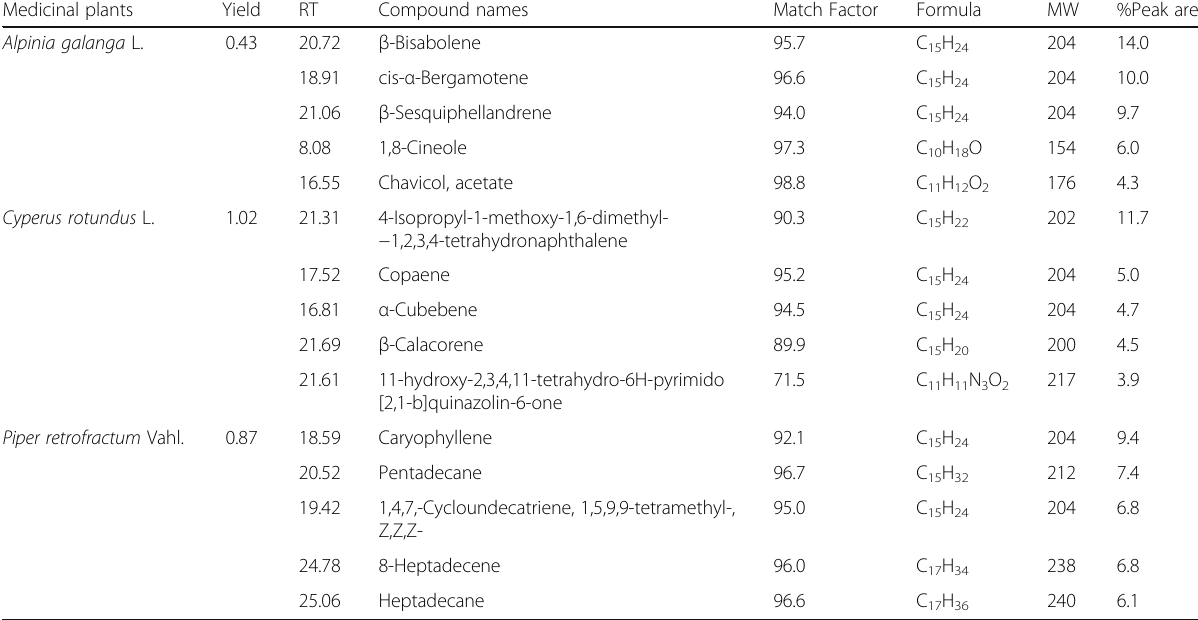
Table 5 Phyto-constituents identified in three essential oils of Piper retrofractum Vahl., Alpinia galanga L., and Cyperus rotundus L Medicinal plants Yield RT Compound names Match Factor Formula MW %Peak area Alpinia galanga L.